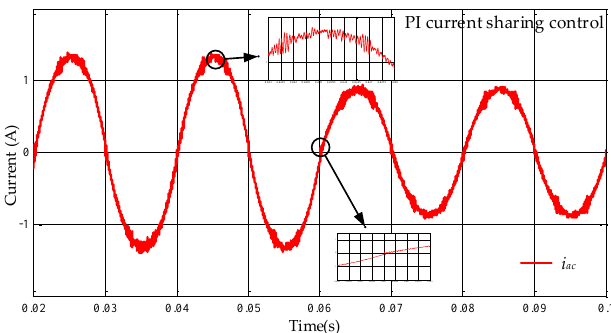
Figure 9. Simulation results of Case 2: output gird current response of interleaved flyback micro-